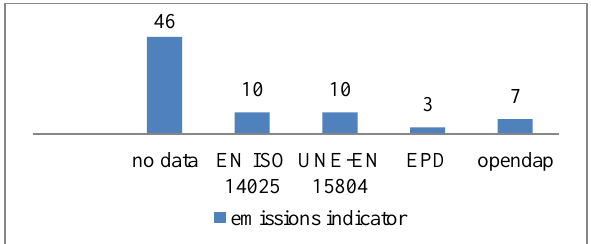
Figure 11. Concrete